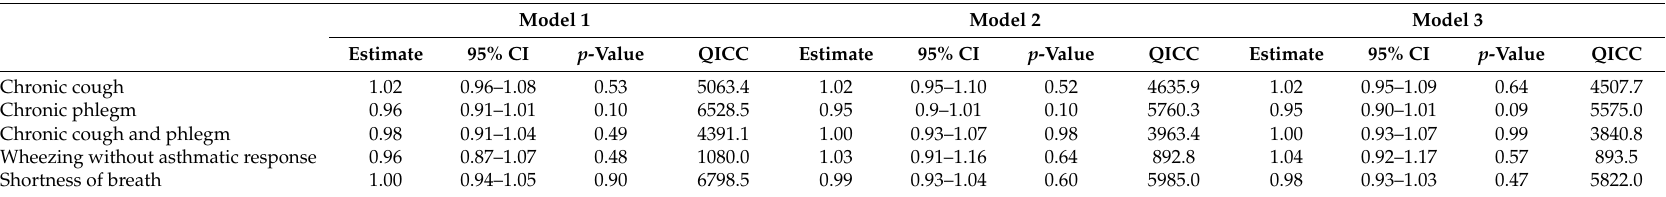
Table 4. E ff ects of toner-handling work on respiratory symptoms by model.